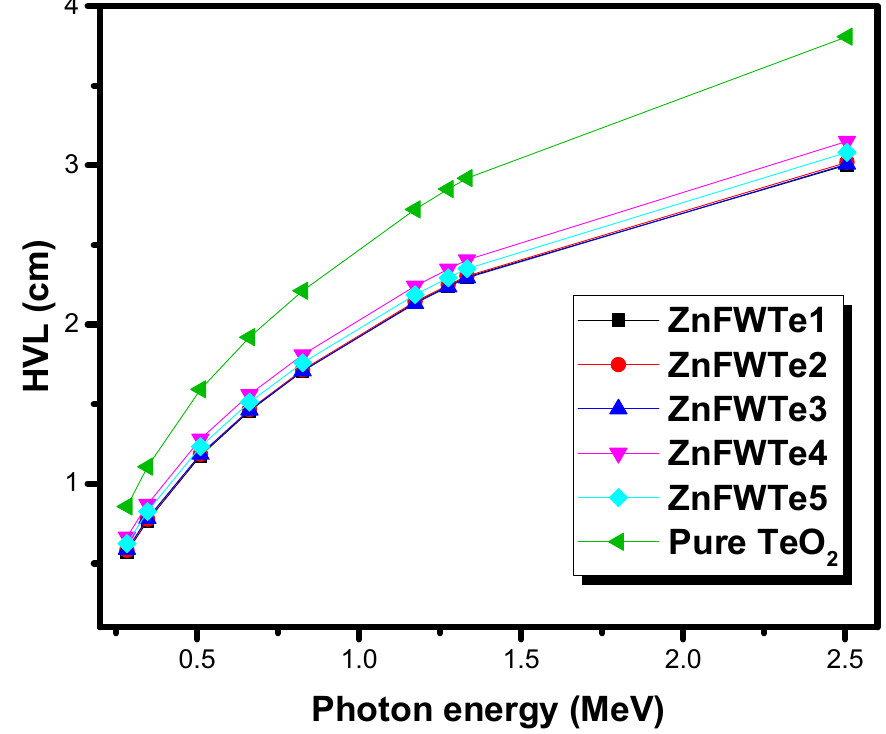
Figure 4. The half value layer for the selected oxyfluoride tellurite glasses.